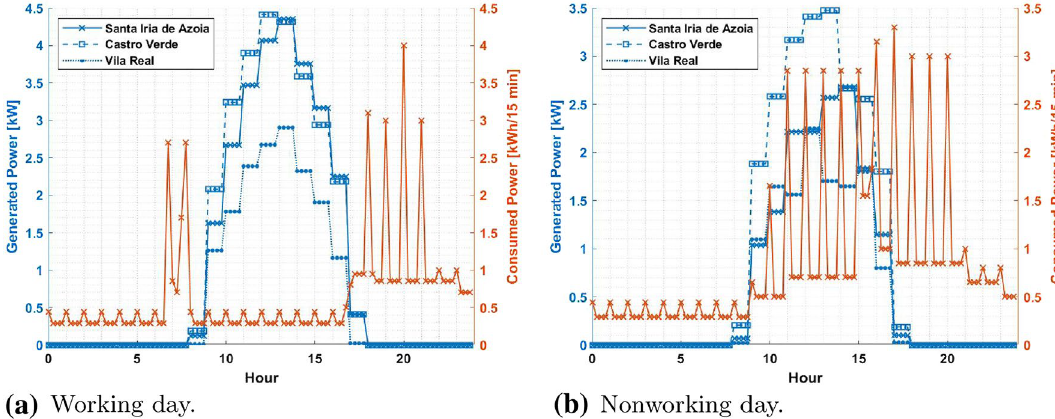
Fig. 17 Generation and consumption curves on the two significant days of January for CsPbI 3 QDs technology